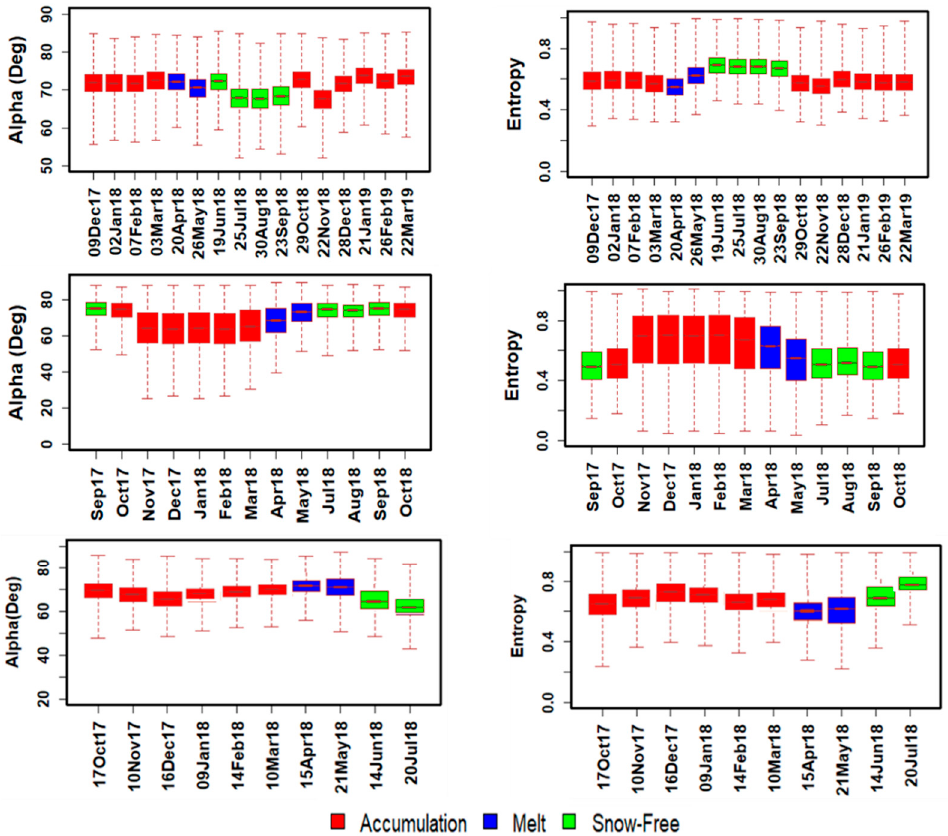
Figure 10. Temporal evolution of Alpha and Entropy parameters over Grand Mesa ( top ), Swiss Alps ( middle ) and North Dakota ( bottom ) for the same areas as Figure 9.